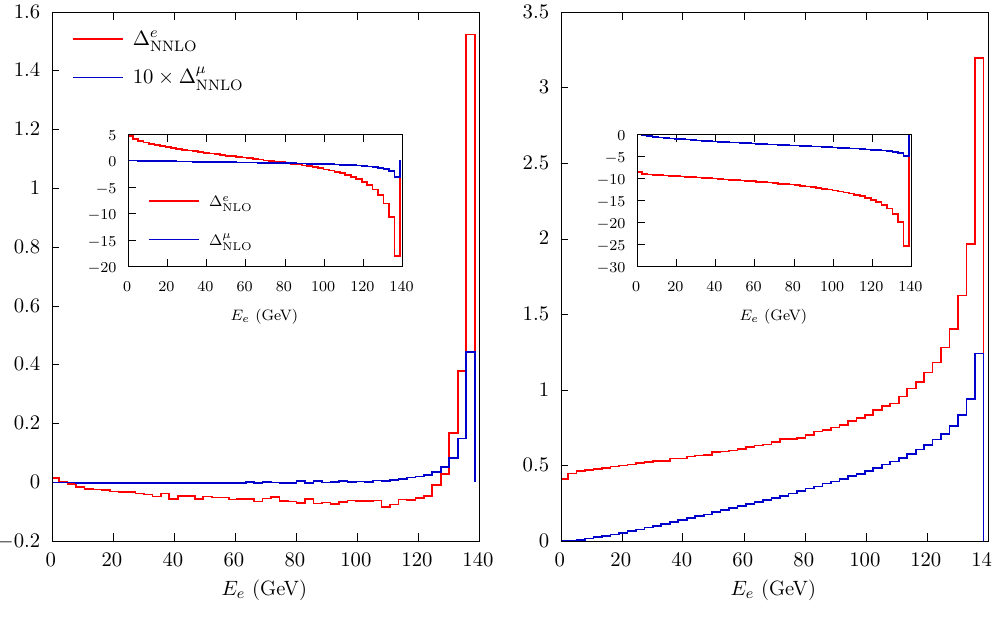
Figure 5 . The same as (cid:12)gure 3 for the electron energy E e